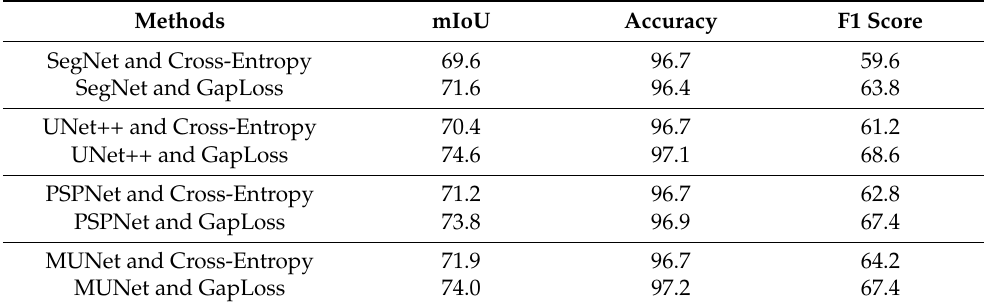
Table 1. The results of Massachusetts Roads